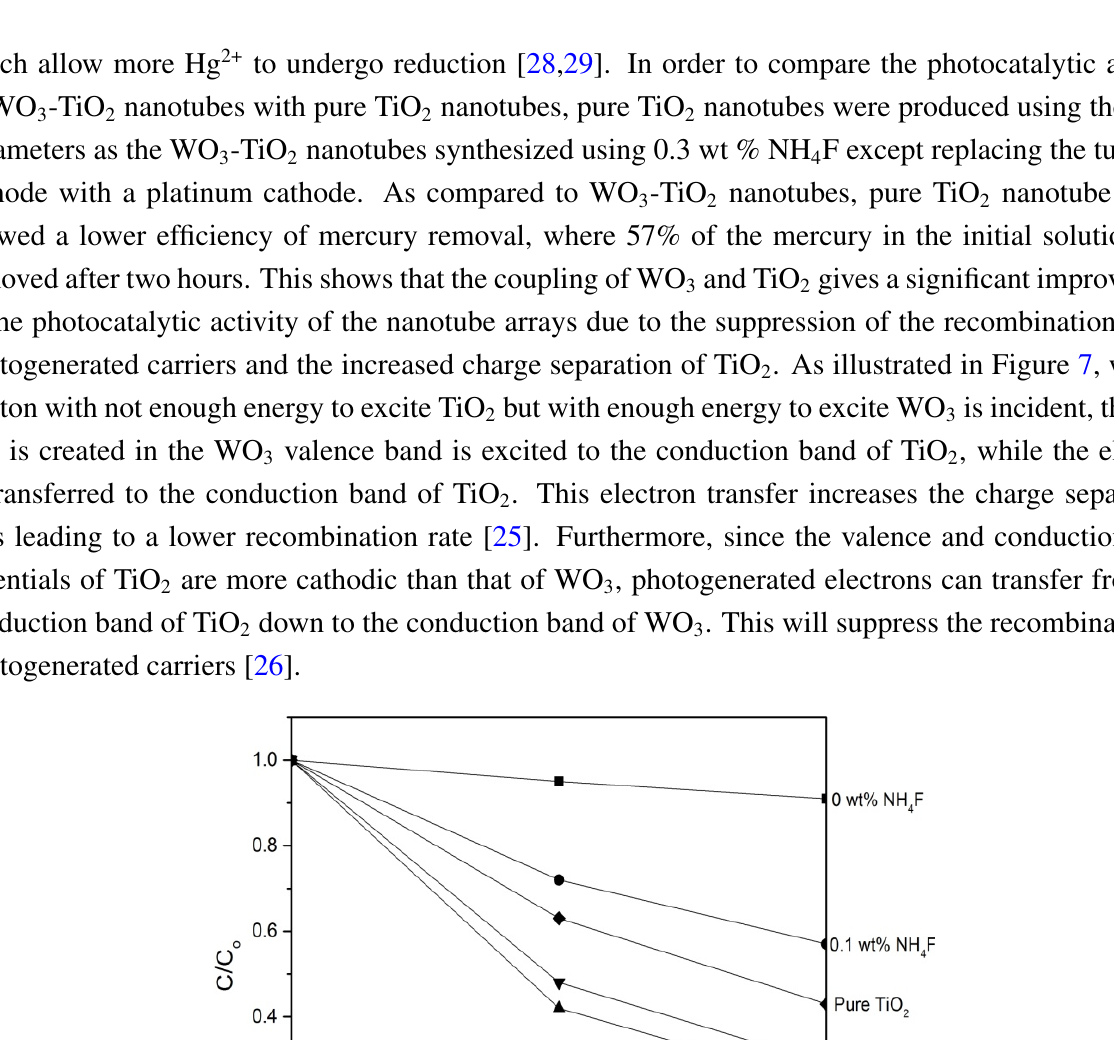
Figure 6. Removal of Hg 2+ by WO 3 -TiO 2 nanotubes and pure TiO 2 nanotubes.